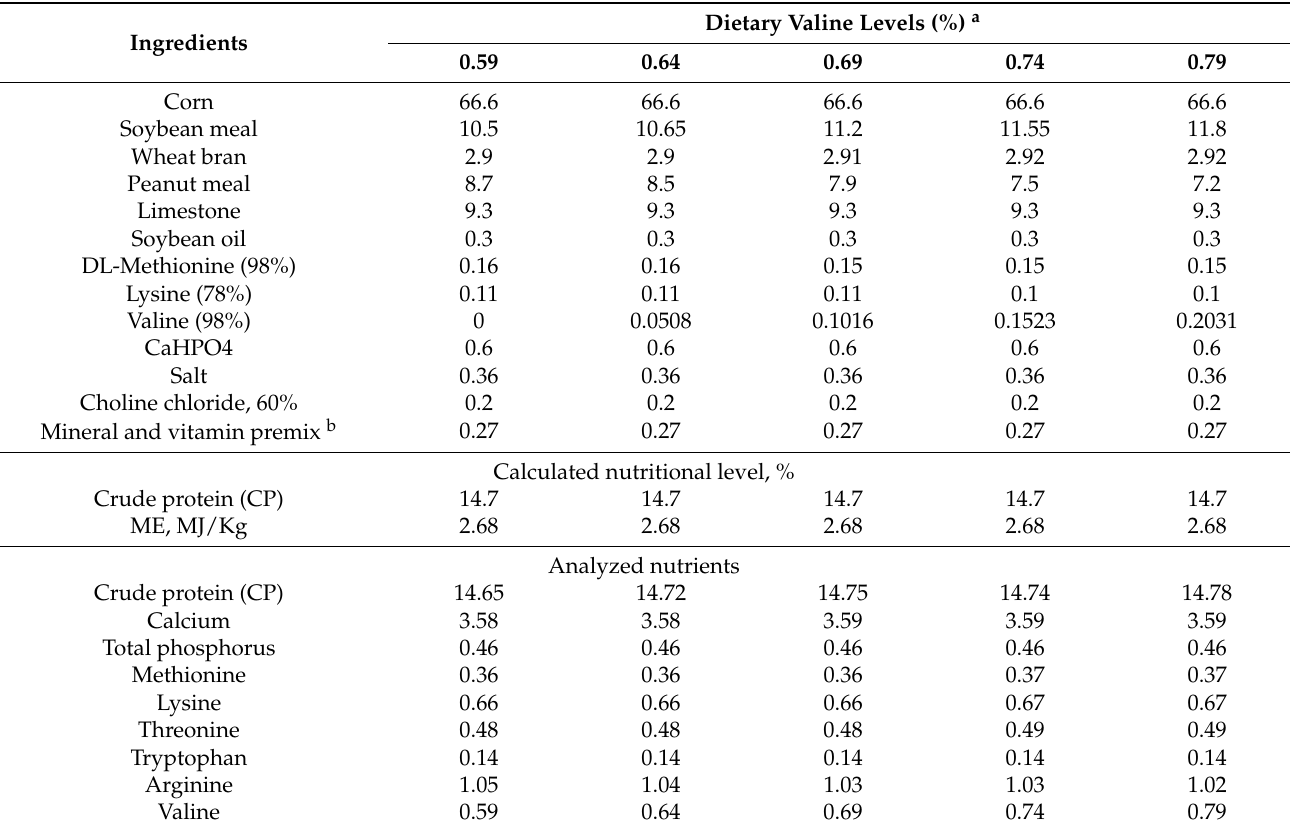
Table 1. Composition and nutrient levels of the basal diet (air-dry